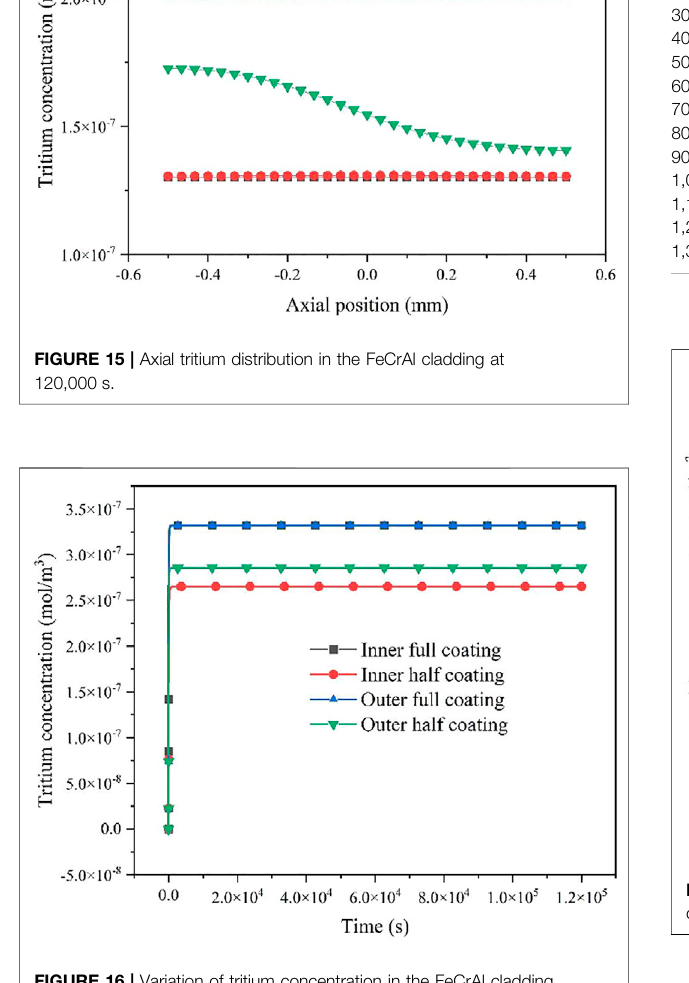
FIGURE 16 | Variation of tritium concentration in the FeCrAl cladding coated with four different types of coating schemes. Based on the abovementioned simulation results, itisclear thattritium concentrationsofthe four different types of coating schemes reach a steady state at t = 10,000 s. There is no signi fi cant difference in the tritium concentration distribution within 1.2 × 10 5 s.